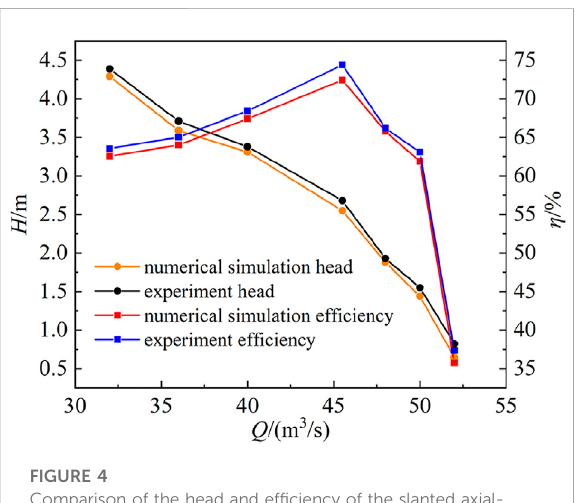
FIGURE 4 Comparison of the head and ef fi ciency of the slanted axial- fl ow